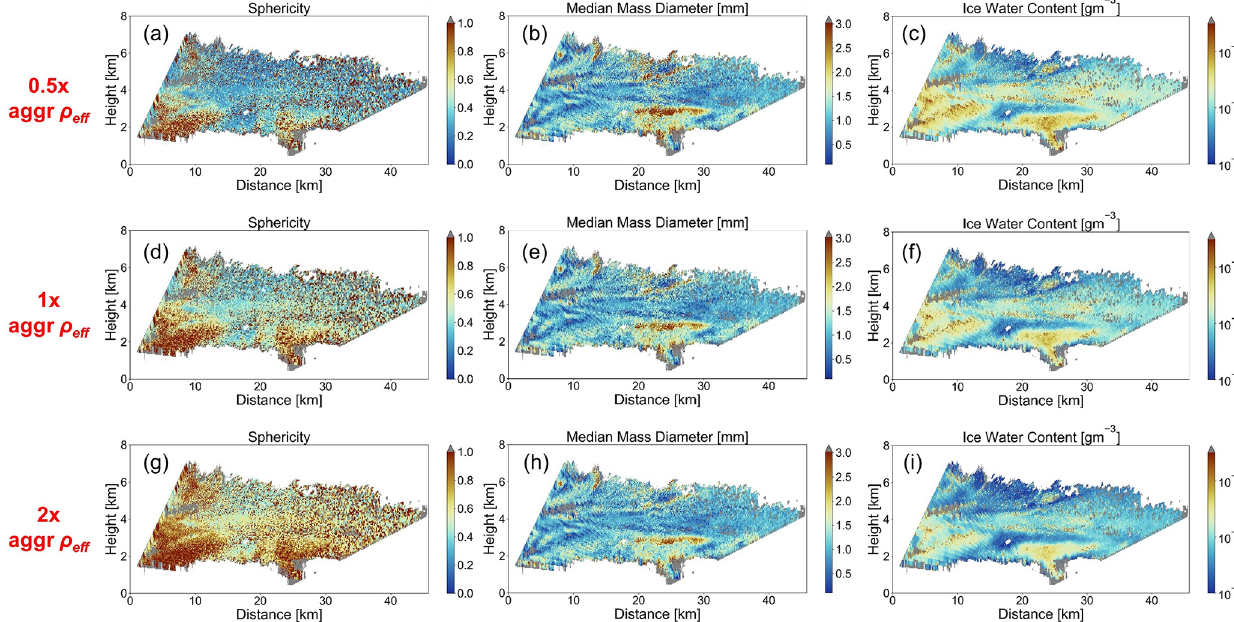
Figure 17. Ice microphysics results for oblate ice spheroids; sphericity, median mass diameter, and ice water content using (a–c) 0 . 5 × ρ eff , (d–f) 1 × ρ eff , and (g–i) 2 × ρ eff from Yang et al. (2000) m(D max ) of aggregates. For better visualization purposes the − 5, − 15, and − 25 ◦ C temperature levels are not plotted here. Areas where ice-masked and noise-filtered measurement values are located are plotted with gray.